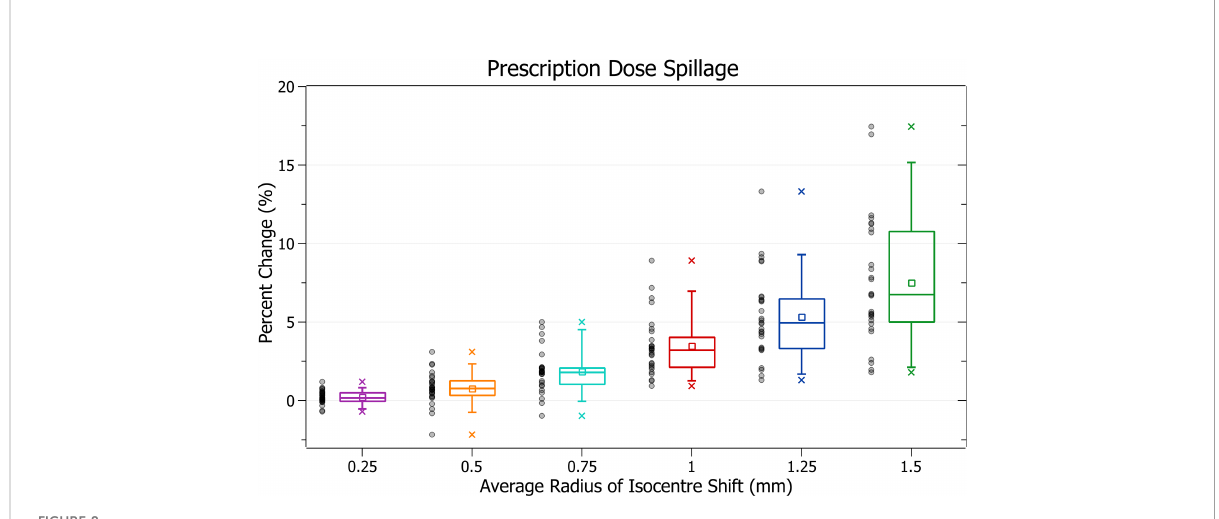
FIGURE 8 Percentage change of prescription dose spillage for different radii of isocentre shift.